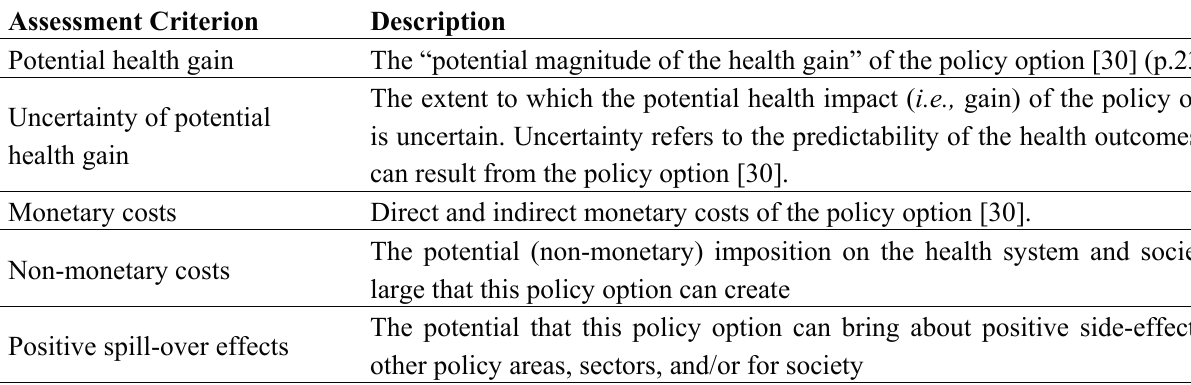
Table 2. Descriptions/definitions of the assessment criteria used in the